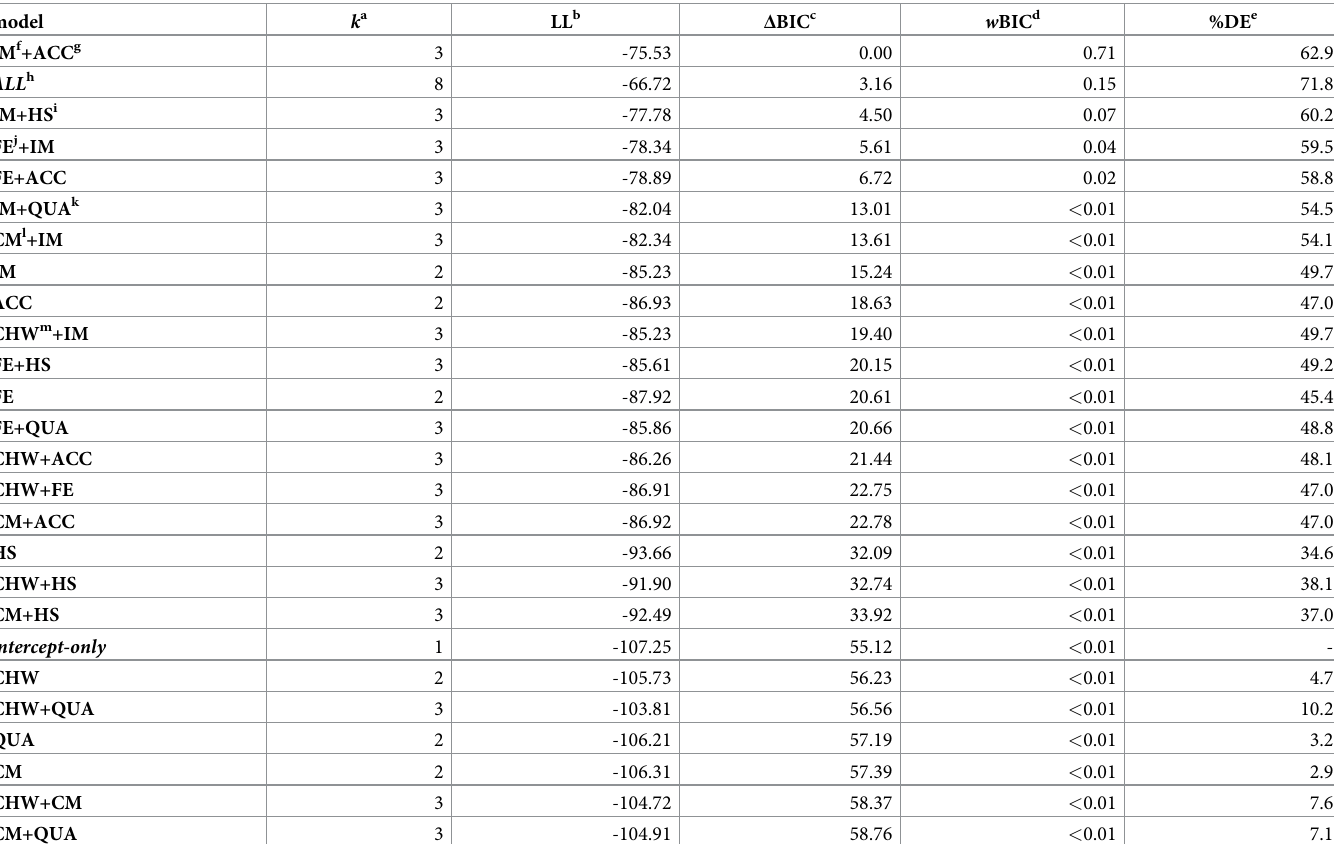
Table 1. Candidate general linear models of the highest-ranked variable from each theme (1. availability of family planning, 2. quality of family planning, 3. educa- tion, 4. religion, 5. mortality, 6. socio-economics) in relation to variation in fertility among 64 low- and middle-income countries.